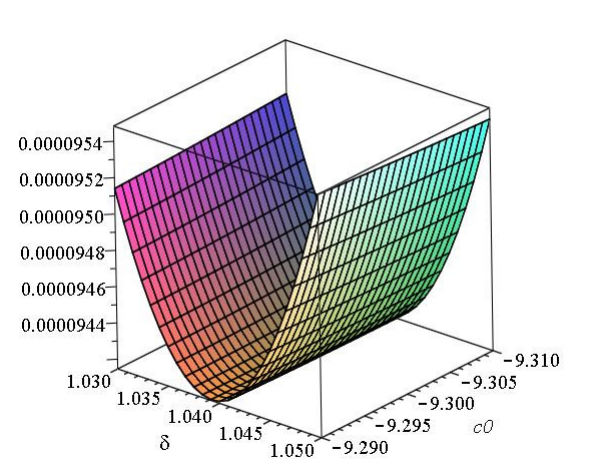
Fig. 3 Plot of E ( c 0 , δ ) , the squared residual error over η ∈ [ 0 , 499 ] as a function of c 0 and δ using parameter values Le = 3, Nb = 1, Pr = 5, Nt = 0, n = 1, A = 7 . 8902. The error function has minimum E ( c 0 , δ , A ) = 9 . 41 × 10 − 5 where c 0 = − 9 . 30195 and δ = 1 . 03944.